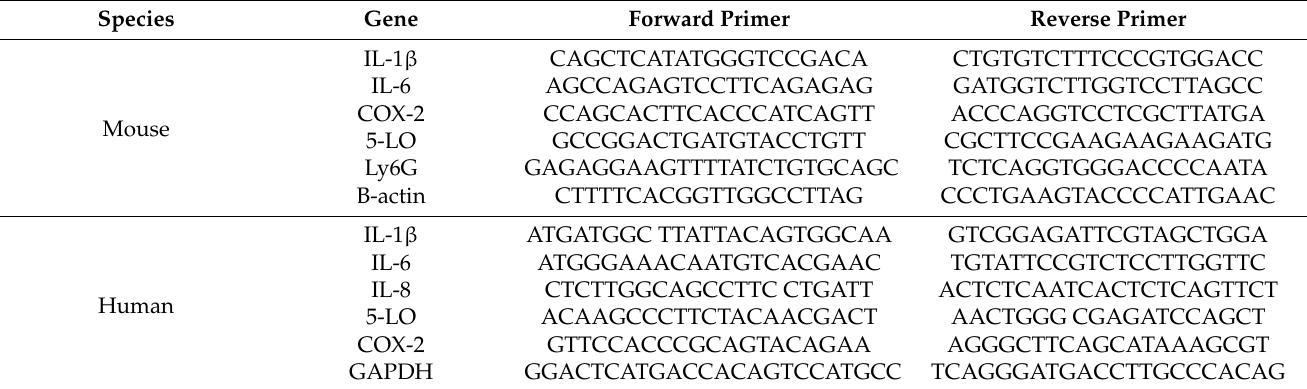
Table 1. Primer sequences for